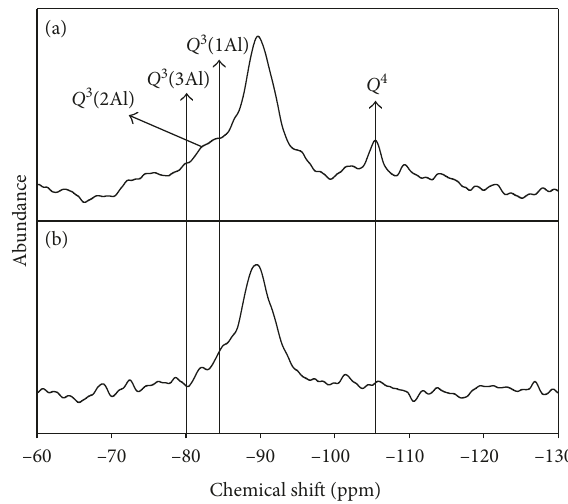
Figure 4: 29 Si NMR spectra of (a) regenerated soil sample treated by air and (b) fresh soil.